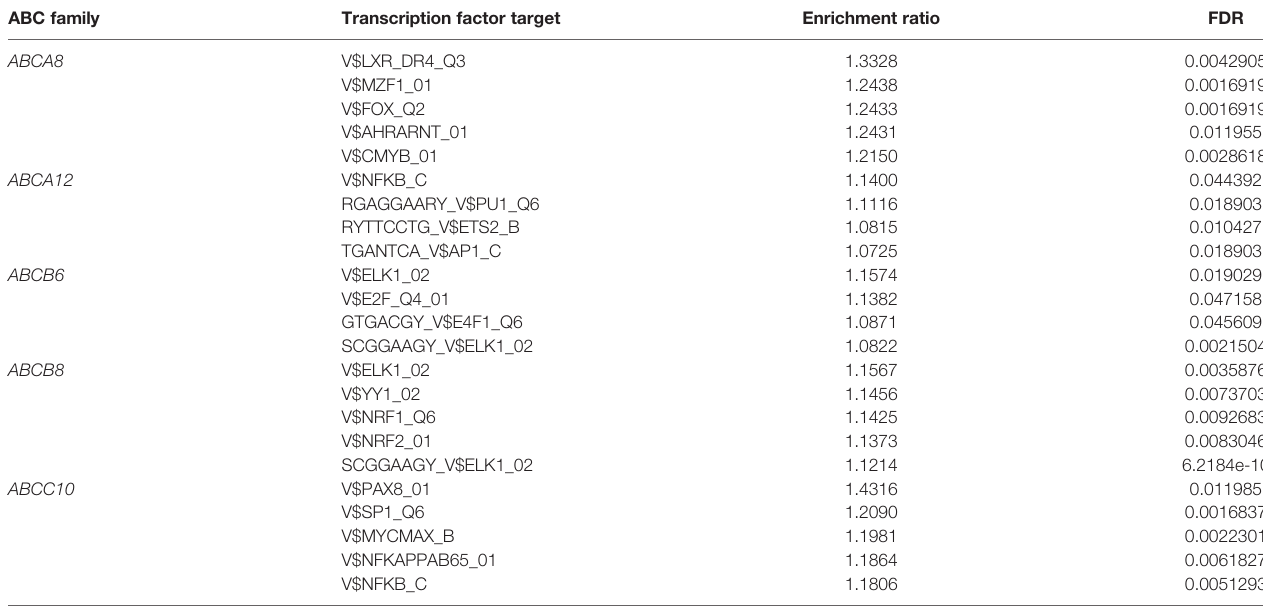
TABLE 3 | Transcription factor targets of the fi ve hallmark ABC transporters in